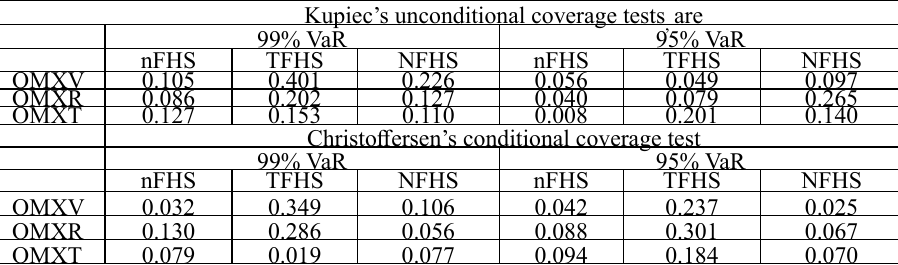
Table 5. Backtesting results based on the Monte Carlo